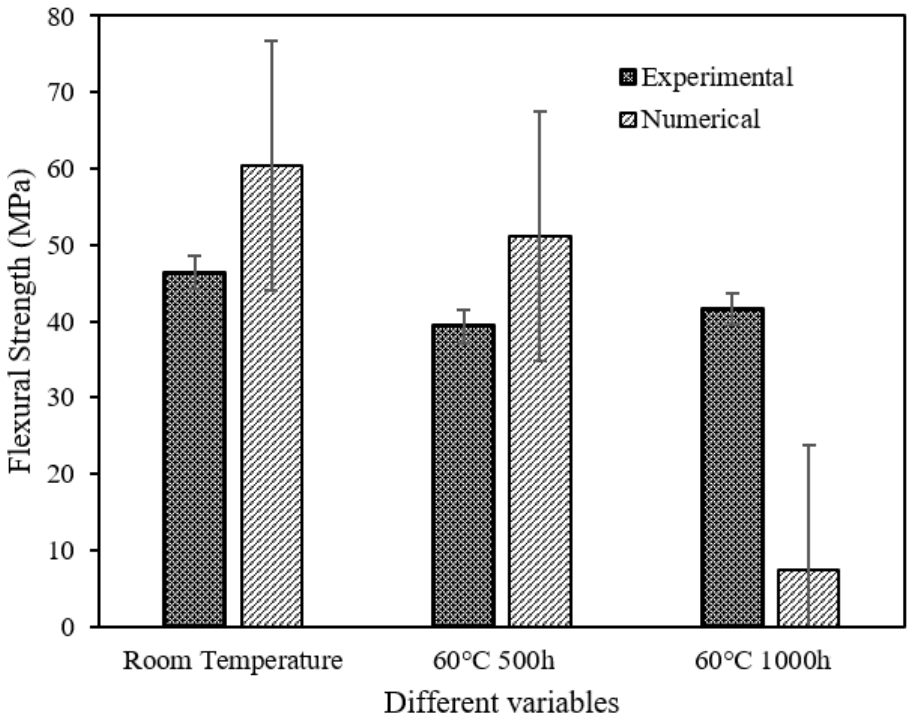
Figure 19. Comparison between experimental and numerical flexural strength of SFRE.